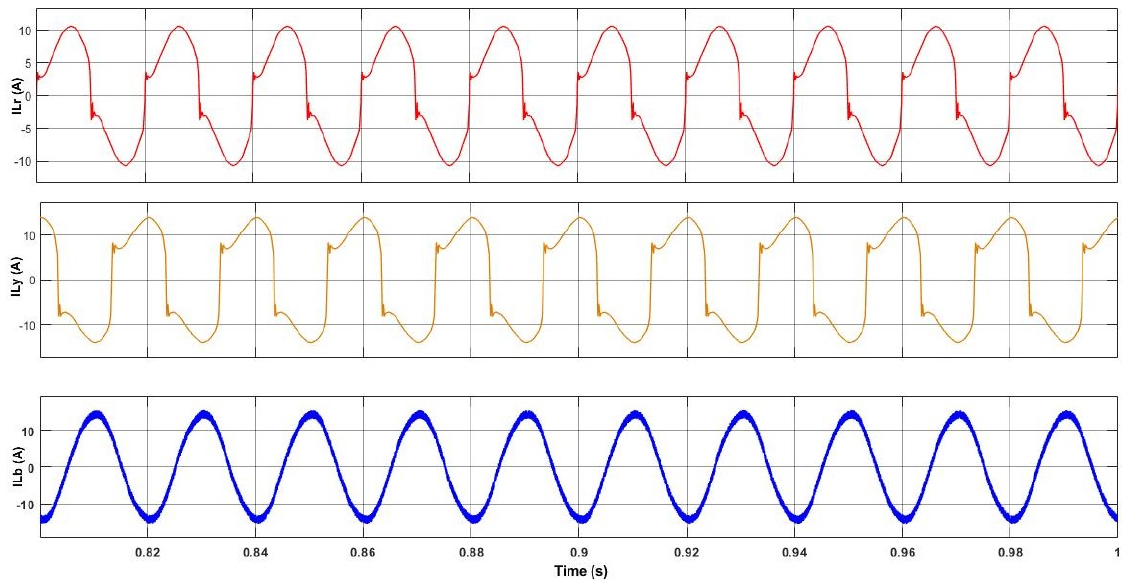
Figure 10. ILr: R-phase load current, ILy: Y-phase load current, and ILb: B-phase load current.